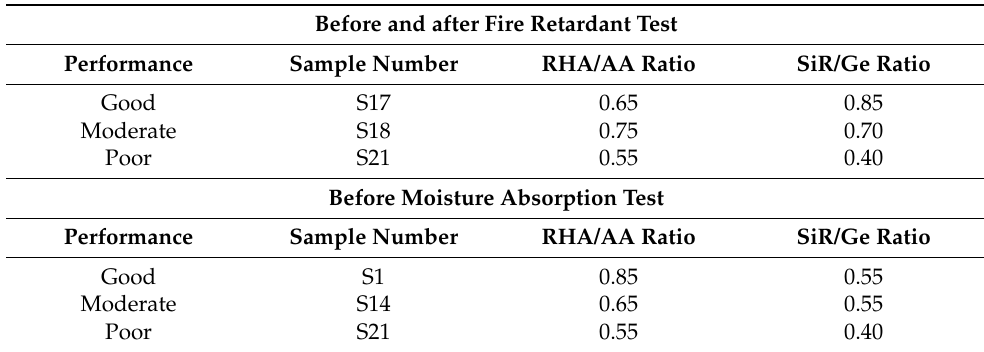
Table 9. Performance of samples in fire retardant and moisture absorption